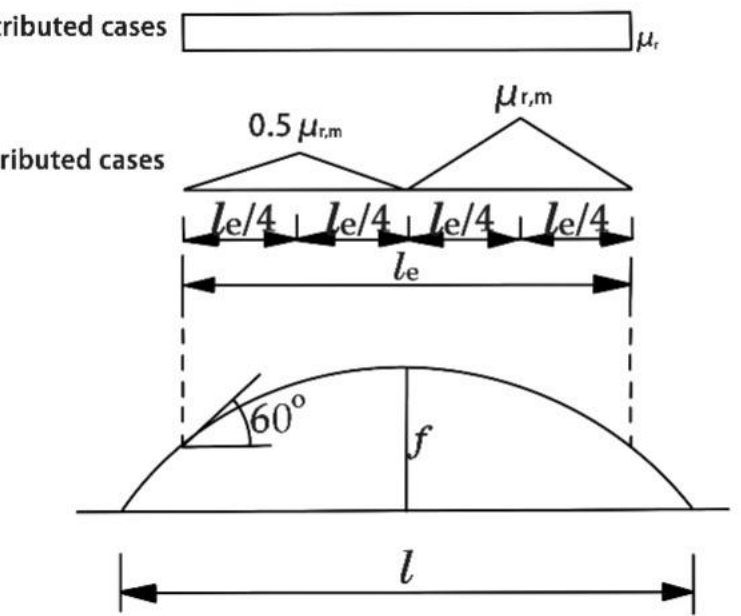
Figure 6. The snow distribution coefficient of the arch